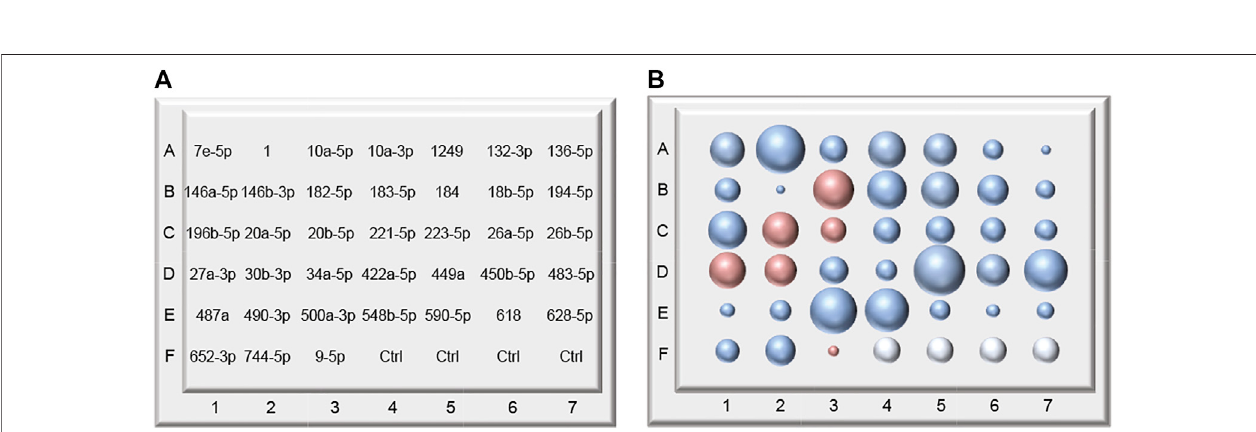
FIGURE 5 | A hypothetical model of an alcohol abuse microRNA biomarker chip. (A) The chip contains a panel of 38 microRNAs characteristic of alcohol abuse. Four spots are designated to controls (bottom, right corner). (B) Results characteristic for alcohol abuse. The size of a sphere corresponds to the change in microRNA expression.UpregulatedmicroRNAsareshownasblue sphereslargerthan controls,downregulatedspheresareshownasspheres smallerthancontrols.Theredcolor depicts in fl ammatory microRNAs.